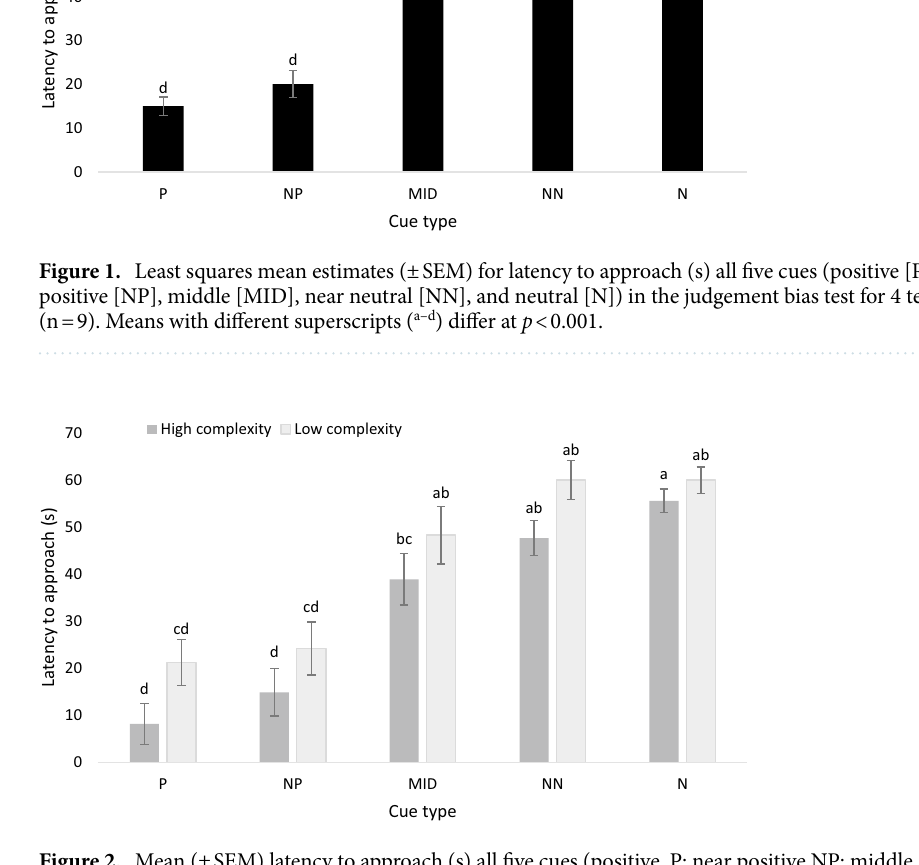
Table 1). Pairwise differences in latency to approach cues were not found for the density treatment. No interaction effect of enrichment and stocking density was found on latency to approach cue types. Gait.